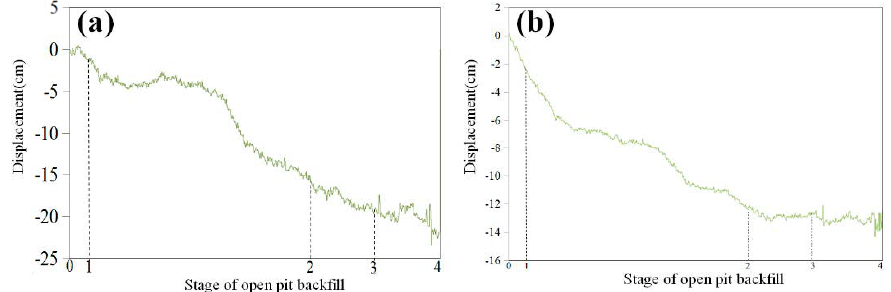
Figure 7. The overall displacements distributions in the horizontal ( a ) and vertical ( b ) directions.